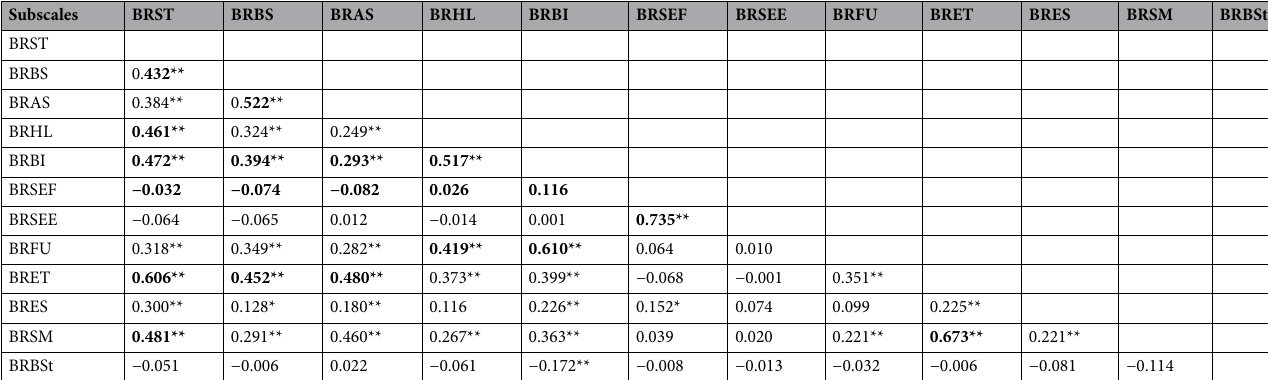
Table 4. Inter-scale correlation of EORTC QLQ BR45 Amharic version among breast cancer patients in Ethiopia, 2021. Systemic therapy side effects (BRST); Breast symptoms (BRBS); Arm symptoms (BRAS); upset by hair loss (BRHL); Body image (BRBI); Sexual functioning (BRSEF); Sexual enjoyment (BRSEE); Future perspective (BRFU); Endocrine therapy scale(BRET); Endocrine sexual(BRES); Skin mucosis(BRSM); and Breast satisfaction(BRBSt). Significant values are in bold.